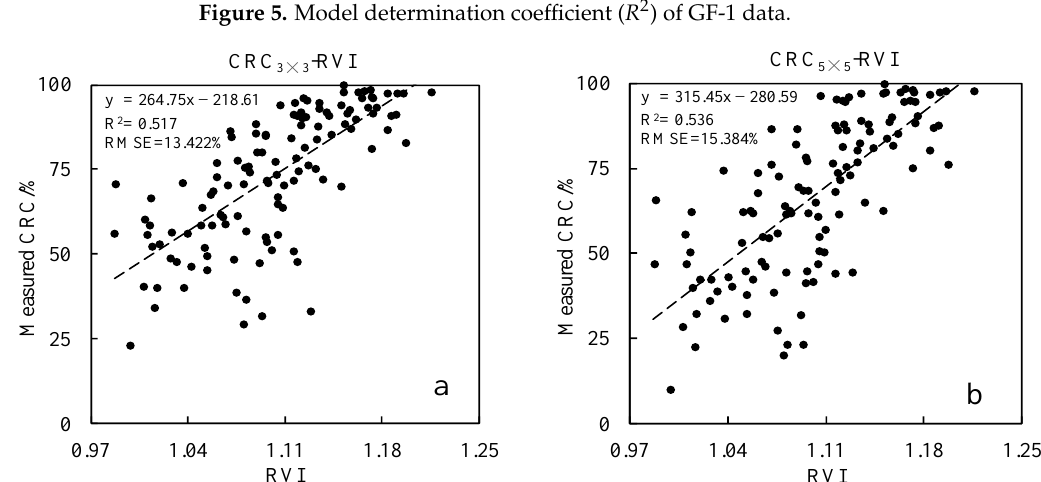
Figure 6. Remote sensing estimation of wheat coverage based on RVI after two filtering processes of GF - 1 data (filter scale 3 × 3 ( a ), filter scale 5 × 5 ( b )).